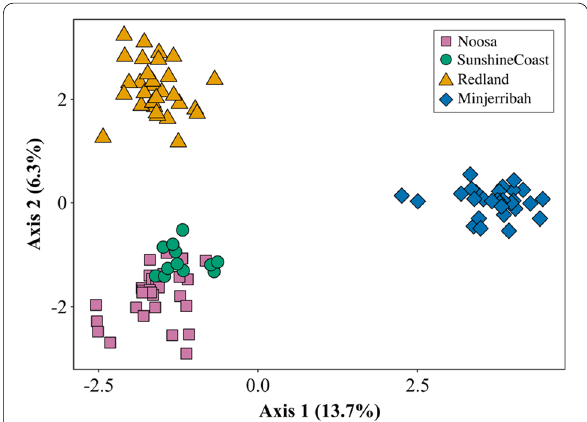
Fig. 5 Location was found to significantly influence host genetic differentiation (F st 0.017–0.153, P < 0.05; Additional file 2: S5) across = South East Queensland. Each dot point represents the genetic profile of an individual koala ( n =